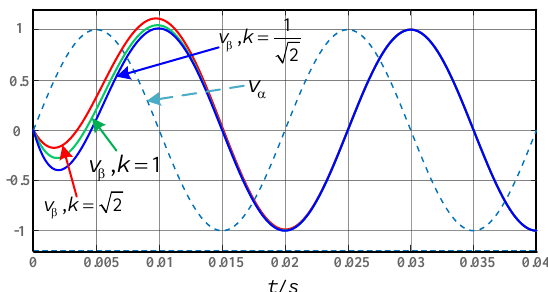
Figure 4. Dynamic response curve of Q (s).